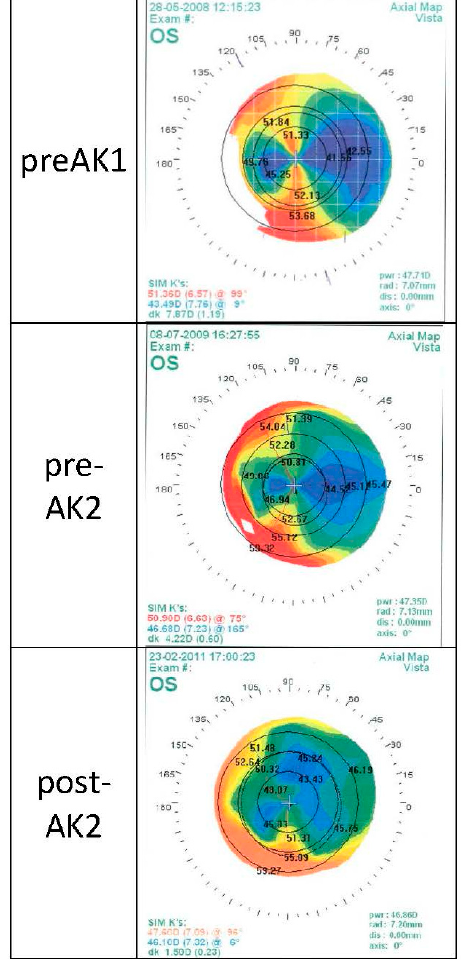
Figure 3. EyeSys topography maps of a patient that underwent repeated astigmatic keratotomy (AK) operations after a Penetrating keratoplasty (PKP). This patient had a positive outcome with a minor decrease in the astigmatism after the first AK treatment, and a significant decrease after the second AK treatment, and no significant change in the axis. Abbreviations: pre-AK1: before